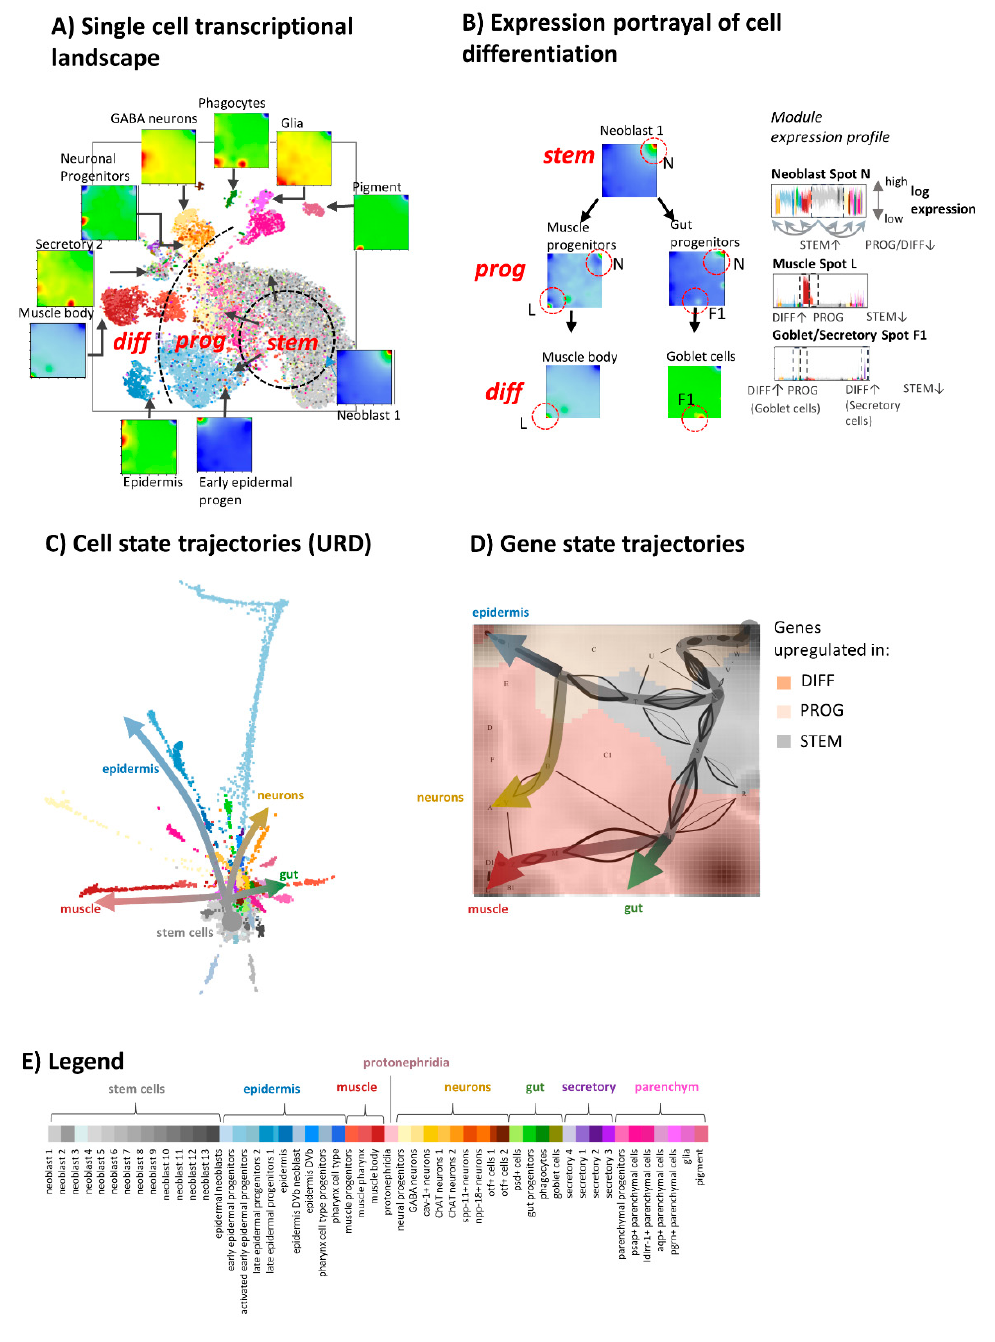
Figure 2. SOM portrayal of the developing planarian single cell transcriptome: ( A ) Single-cell resolved tSNE plot (cell types are color-coded as shown in the legend in part E). SOM expression portraits of selected cell types provide a glimpse on cell and gene transcriptional space. ( B ) Expression portraits of stem cells and of differentiating progenitor and differentiated muscle body and a goblet cells show overexpression spots at different positions as indicated by the dashed circles. The spot profile reveals specific up regulation of the spots in the respective tissue specific cells. ( C ) The URD [40] plot resolves multibranched single-cell developmental manifolds. Paths of selected tissue types are indicated by arrows. ( D ) Gene activation trajectories of cell differentiation from stem cells into four different tissues were calculated by means of maximum flow on SOM embedding. ( E ) Legend of colors used for cell-type assignment (see also [29]). The color code is used throughout the paper.